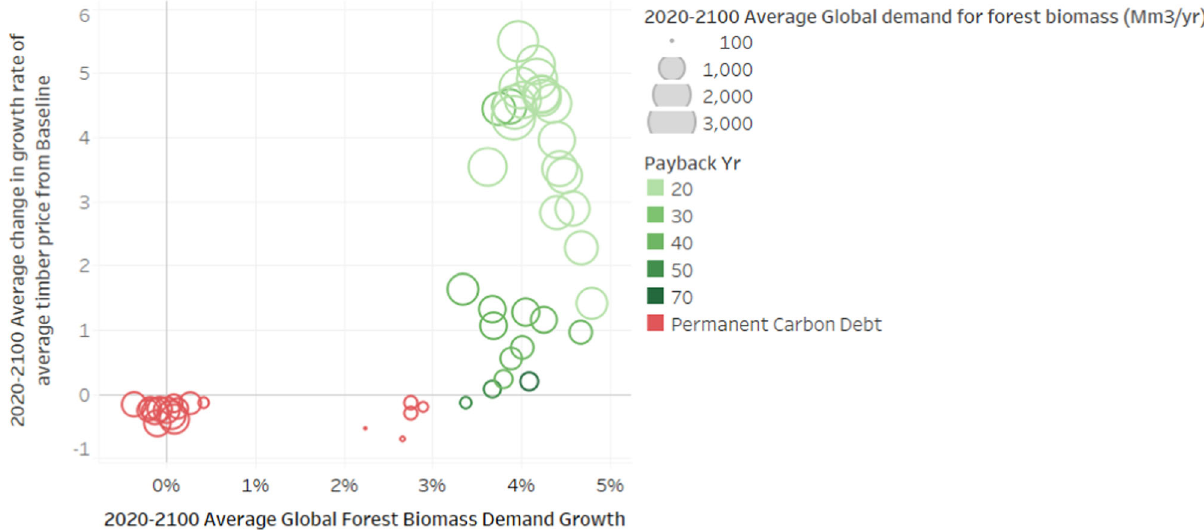
Fig. 3 Payback period of forest carbon debt under 51 demand scenarios divided by annual average forest biomass demand growth rate and change in average timber price growth from baseline, 2020 – 2100 (all carbon pools included). Each circle shows the payback period of the forest carbon debt per scenario according to the annual average forest biomass demand growth rate ( x -axis) and change in average timber price growth from baseline ( y -axis). All carbon pools are included in the carbon debt calculation. The color of the circle identi fi es the payback period: scenarios that never recover the carbon debt are in red (permanent carbon debt), while scenarios that recover it between 20 and 70 years are in green. The size of the circle represents the global annual average biomass quantity supplied between 2020 and 2100 and it ranges from 100 to 3000 Mm 3